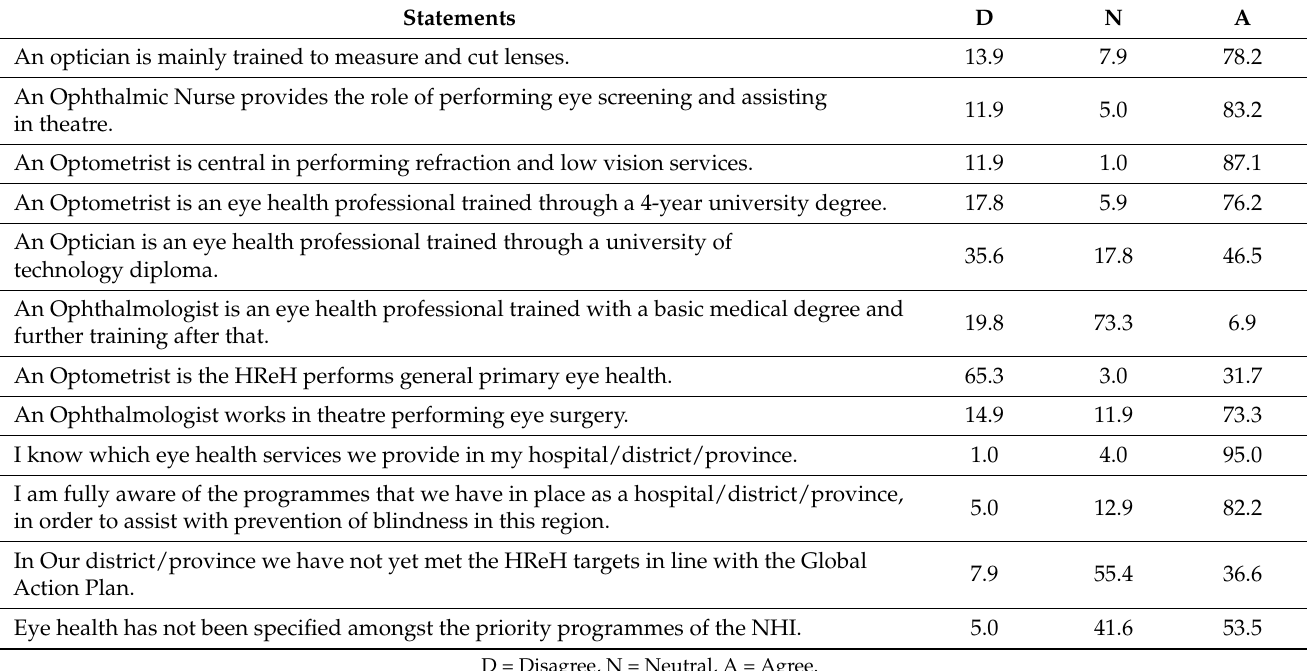
Table 2. Frequency distribution of responses related to knowledge regarding eye health.